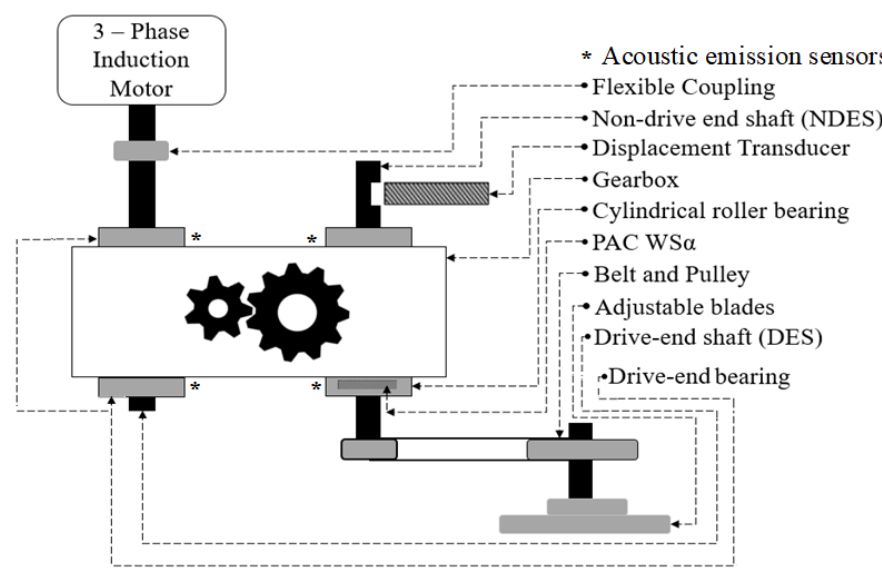
Figure 1. Schematic of the fault simulator.